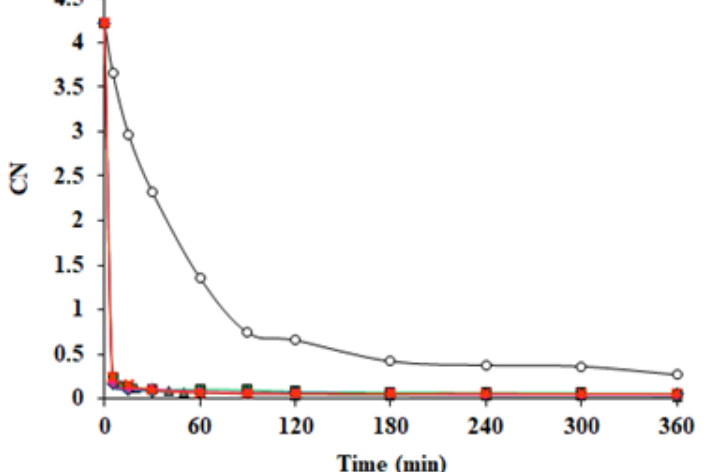
Figure 7. Evolution of color number (CN) values with time in absence of catalyst ( ), and in presence of the eggshell ( (cid:78) ) and the supported catalysts: Fe 5% ( + ), Fe 15% ( × ), Cu 5% ( (cid:4) ), and Cu 15% ( (cid:7) ). In all cases, T = 150 ◦ C, P = 40 bar, pH = 7.5, initial HA concentration = 400 ppm and catalyst concentration = 1 g/L.